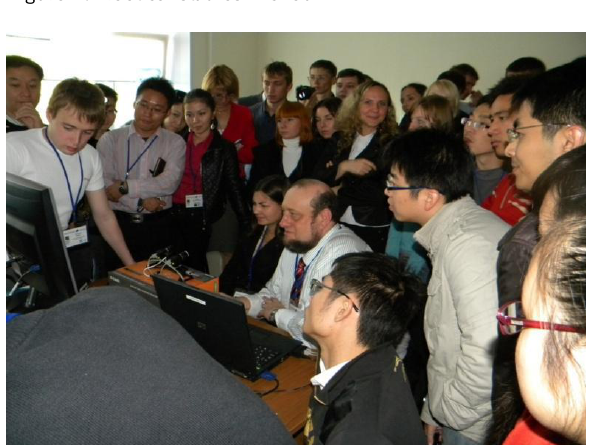
Figure 2. Master class by Prof. Levin